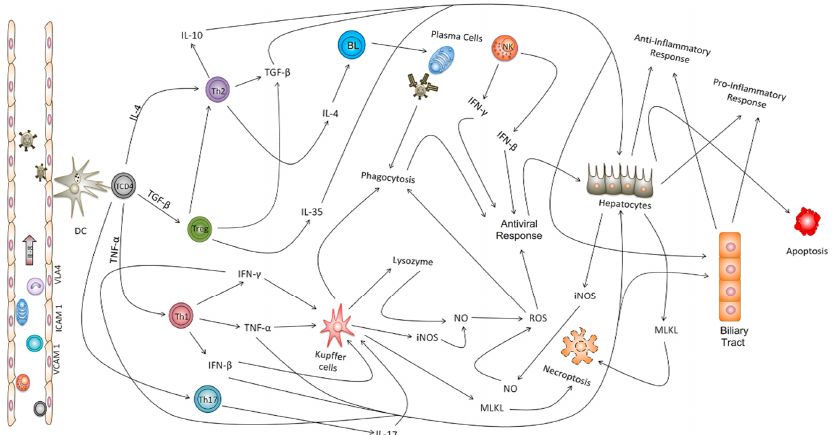
Figure 7. Integrated network and possible mechanism of in situ immune response in the hepatic parenchyma of non-human primates ( Saimiri spp.) infected with the yellow fever virus. After the infection, YFV is recognized by dendritic cells (DC), initiating the immune response by triggering immune cells that will produce the mechanisms to activate different local cells in liver and the production of cytokines and chemokines to drive the organism defenses. Both innate and adaptive immune cells have an important role in triggering the adequate response and the Treg cells are directly involved in the regulation of an equilibrated immunologic response in efforts to control the damage caused by YFV in the hepatic tissue.